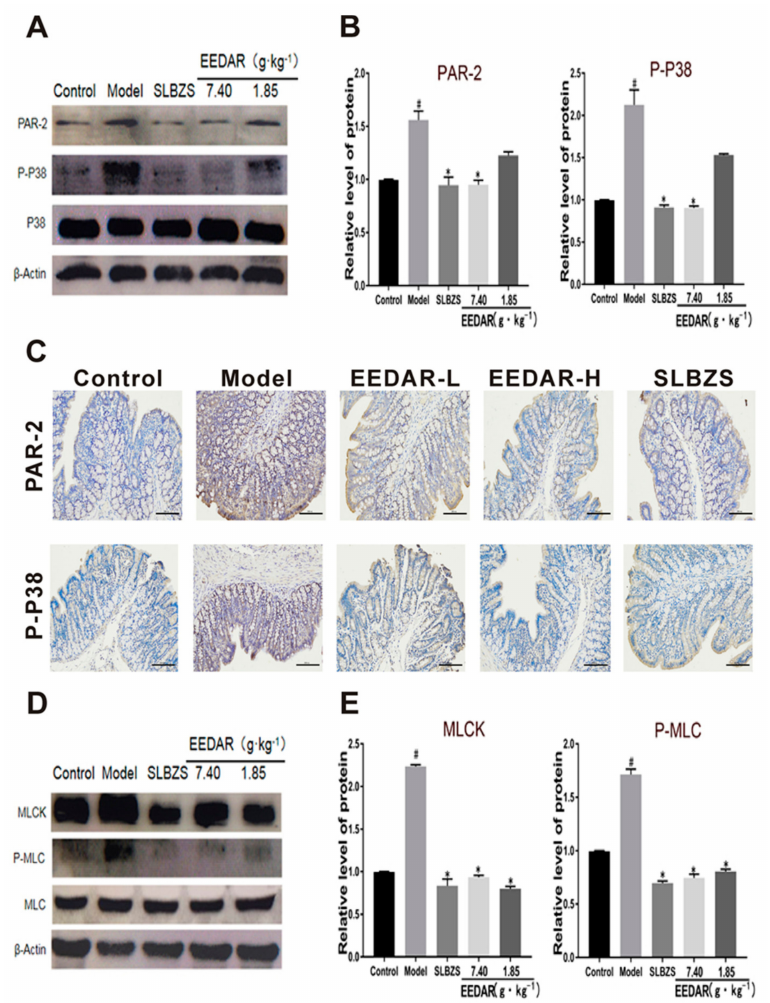
Figure 6. E ff ects of EEDAR on signaling molecules that regulate TJ structure and function in spleen-deficiency diarrhea rats ( n = 3). The phosphorylation levels of p38 and PAR-2 in total colon homogenates were measured by Western blot analysis ( A , B ). Representative images of immunohistochemistry sections (200 × magnification) from PAR-2 and P-P38 ( C ) colons indicated di ff erent pathological changes in spleen deficiency diarrhea rats treated with EEDAR-L (1.85 g · kg − 1 ), EEDAR-H (7.40 g · kg − 1 ), and SLBZS. Total protein levels of P-MLC and MLCK were measured by Western blot analysis ( E , F ). Bands were quantified and values normalized to non-phosphorylated protein or β -actin levels. Values represent means ± SEM. # p < 0.05 vs. Control; * p < 0.05 vs. Model. (Scale bar